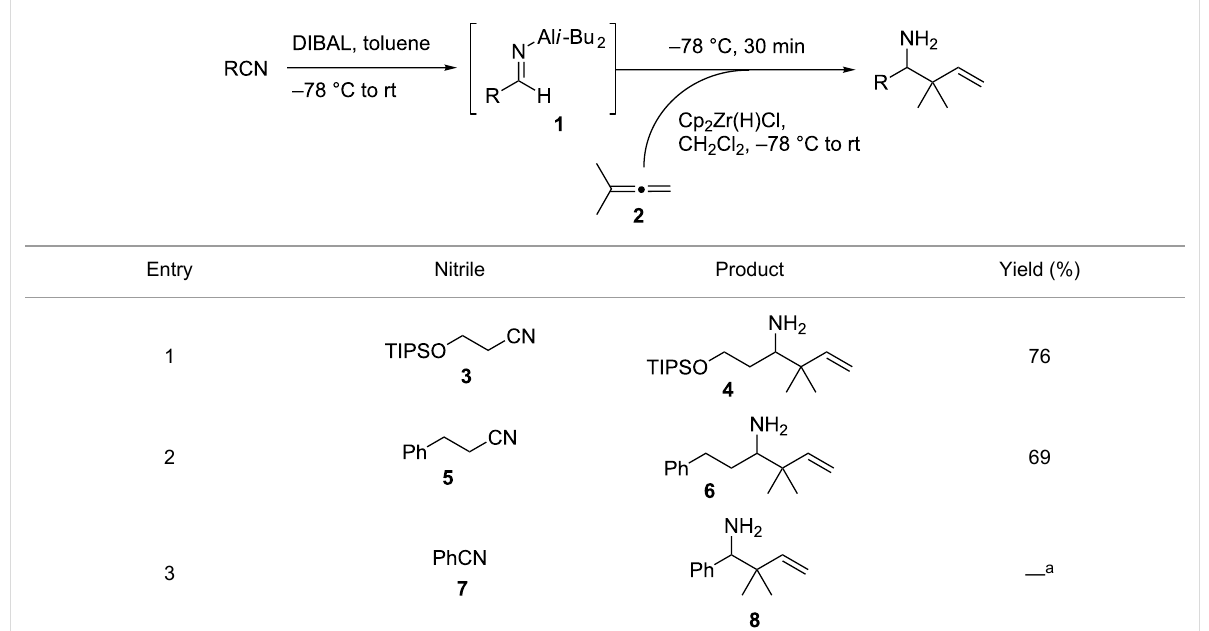
Table 1: Reaction of N -aluminoimines with allylzirconocene derived from allene 2